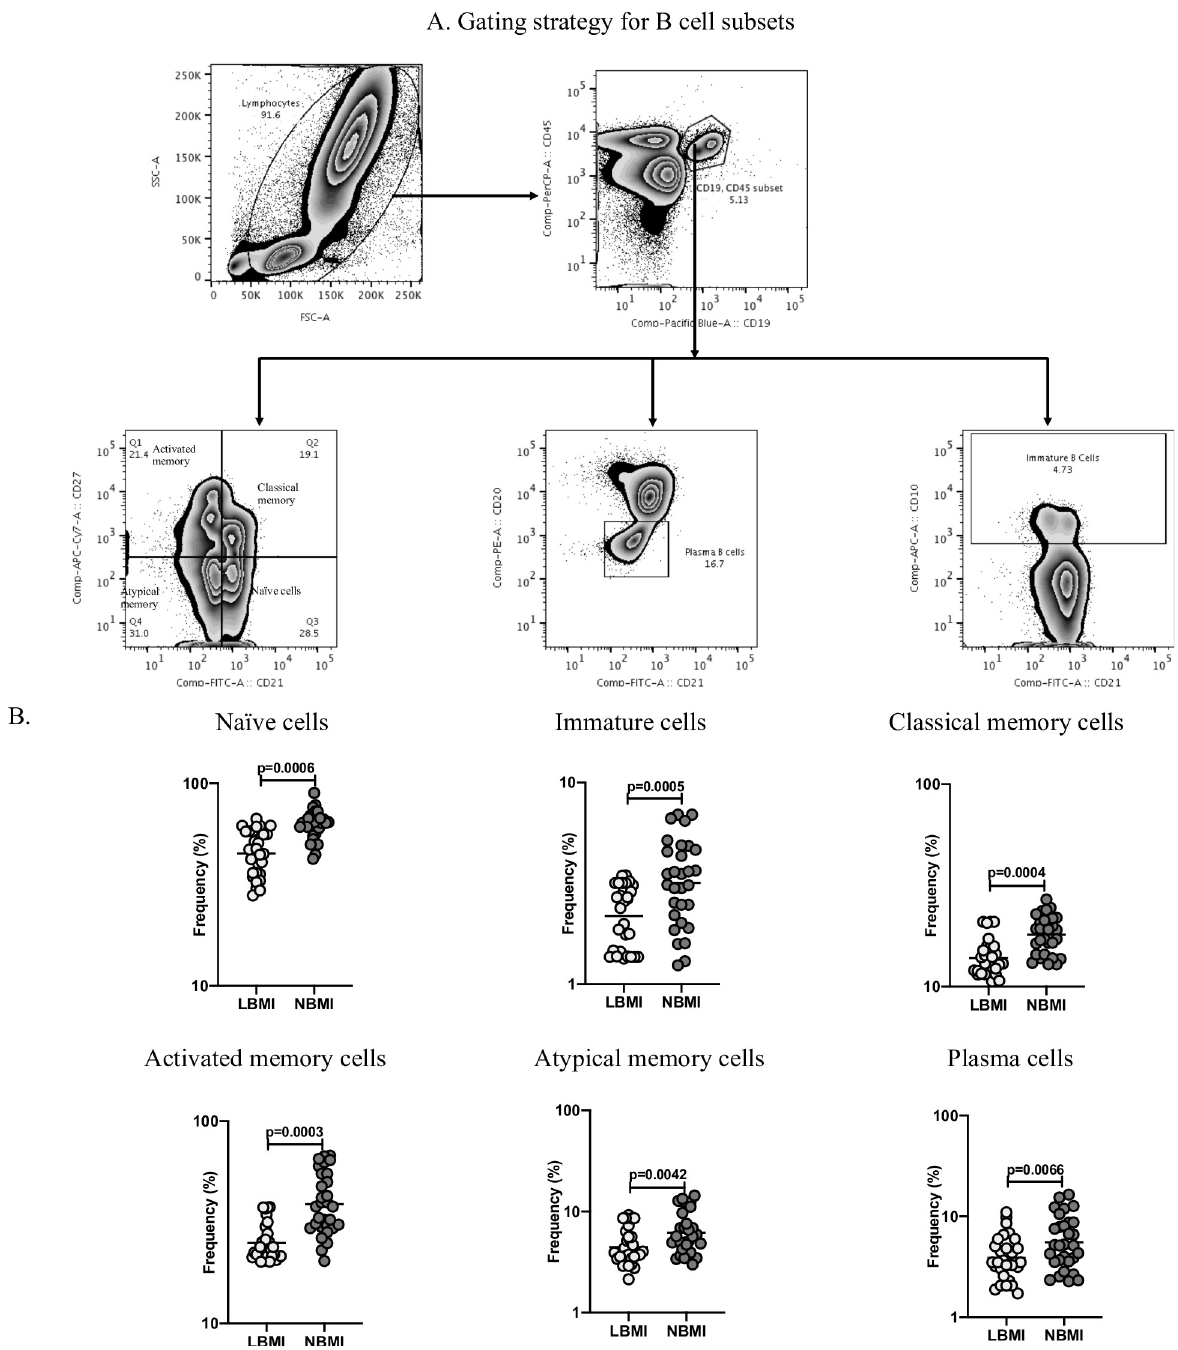
Fig 3. LBMI is associated with diminished frequencies of B cell subsets. (A) Gating strategy for B cell subsets: An illustrative flow cytometry plot from an LTBI-LBMI individual depicting the gating strategy for na ï ve, immature, classical memory (CM), activated memory (AM), atypical memory (ATM), immature and plasma cells from CD45 + CD19 + cells. Na ï ve cells were classified as CD21 + CD27 - ; classical memory (CM) cells as CD21 + CD27 + ; activated memory (AM) cells as CD21 - CD27 + ; Atypical memory (ATM) cell as CD21 - CD27; immature B cells as CD21 + CD10 + ; and plasma cells as CD21 - CD27 - . (B) Frequencies of B cell subsets—na ï ve B cells, classical memory B cells (CM), activated memory (AM), atypical memory (ATM), immature and plasma cells in LTBI-LBMI [LBMI] (n = 30) or LTBI-NBMI [NBMI] (n = 30) group. The data are depicted as scatter plots and each circle represent a single person. Mann–Whitney U-test with Holms correction for multiple comparisons were done to calculate p values.